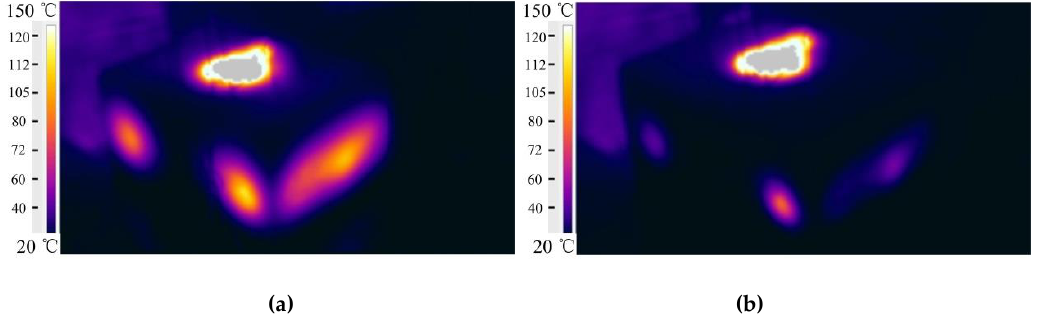
Figure 29. Infrared imaging of the traditional sand mold surface temperature: ( a ) 2000 s and ( b ) 5600 s.